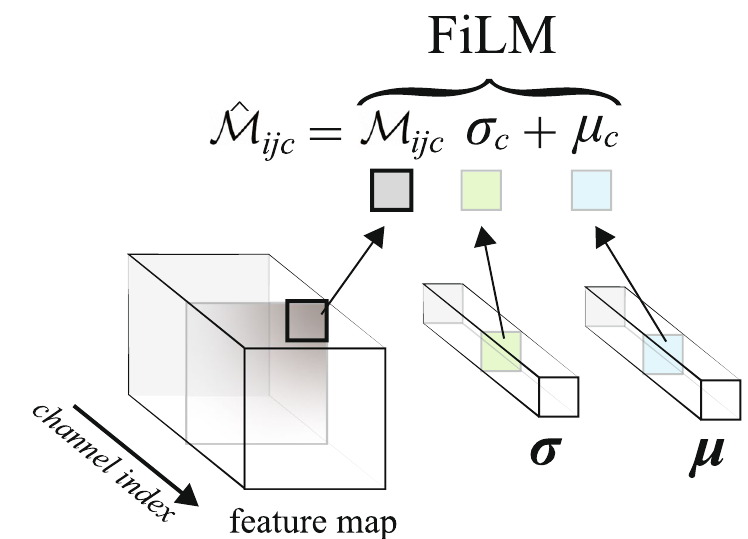
Fig. 3 Illustration of FiLM